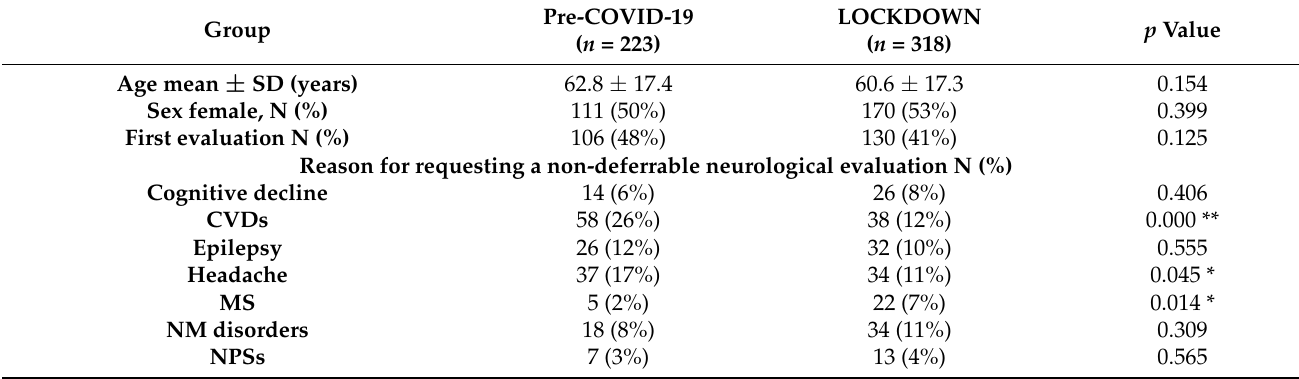
Table 1. Patients’ demographics, reasons for requesting a non-deferrable neurological evaluation, and discharge diagnoses.